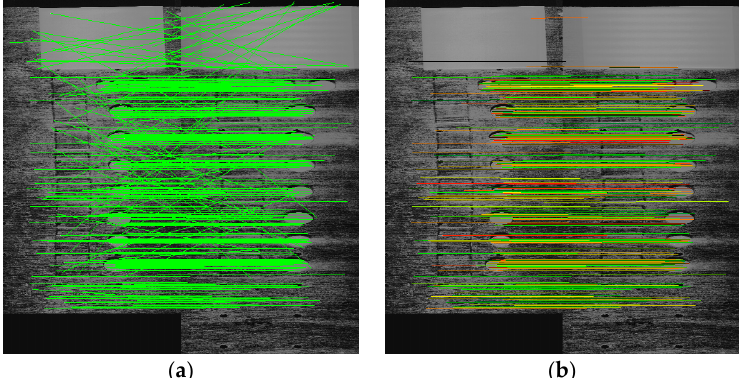
Figure 7. ( a ) Assigned tie point pairs after SIFT nearest-neighbour filtering between VNIR (left part) and SWIR (right part), ( b ) assigned tie point pairs after angle and iterative RANSAC filtering between VNIR (left part) and SWIR (right